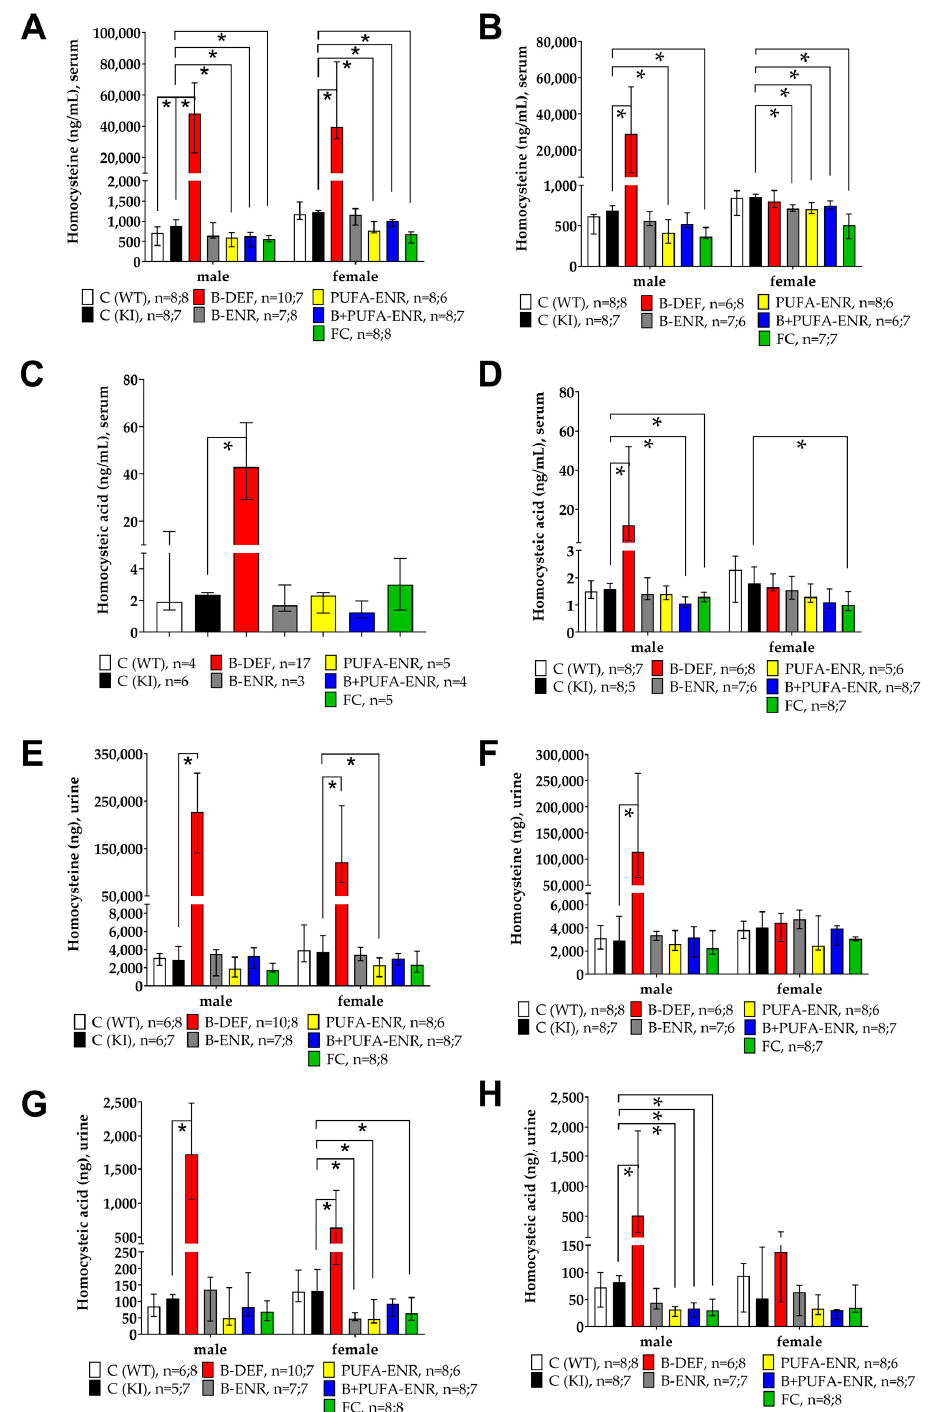
Figure 3. Homocysteine (HCys) and homocysteic acid (HCA) urine and serum levels in 13 and 35 weeks old C57BL/6J and App NL-G-F mice; 8 resp. 30 weeks on experimental diet; all samples analyzed by LC-MS/MS; data presented as median ± IQR; outliers beyond threefold IQR removed; p < 0.05 (Mann-Whitney-U-test) considered statistically significant (*). ( A ) HCys serum levels; 8 weeks on diet. ( B ) HCys serum levels; 30 weeks on diet. ( C ) HCA serum levels; 8 weeks on diet (males and females pooled); samples pooled for analytical method due to low volumes obtained by vena facialis puncture. ( D ) HCA serum levels; 30 weeks on diet. ( E ) HCys urine levels; 8 weeks on diet. ( F ) HCys urine levels; 30 weeks on diet. ( G ) HCA urine levels; 8 weeks on diet. ( H ) HCA urine levels; 30 weeks on